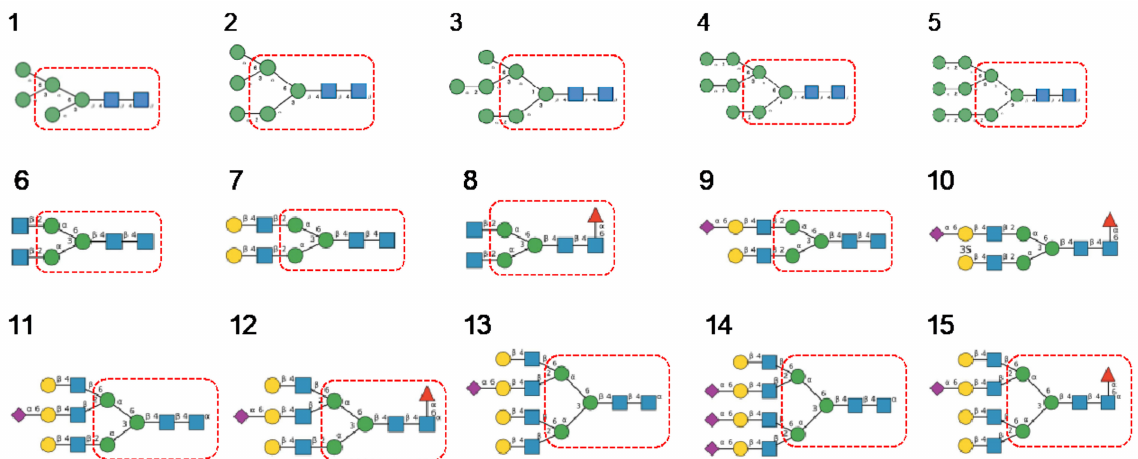
Figure 25. ( 1 – 5 ). High-mannose-type glycans: GlcNAc 2 Man 5 ( 1 ); GlcNAc 2 Man 6 ( 2 ), GlcNAc 2 Man 7 ( 3 ), GlcNAc 2 Man 8 ( 4 ) and GlcNAc 2 Man 9 ( 5 ). ( 6 – 15 ). Complex-type glycans: bi-antennary glycans ( 6 , 7 ), fucosylated bi-antennary glycan ( 8 ), sialylated bi-antennary glycan ( 9 ), sialylated and fucosylated bi-antennary glycan ( 10 ), sialylated tri-antennary glycan ( 11 ), sialylated and fucosylated tr-antennary glycan ( 12 ), sialylated tetra-antennary glycans ( 13 , 14 ) and sialylated and fucosylated tetra-antennary glycan ( 15